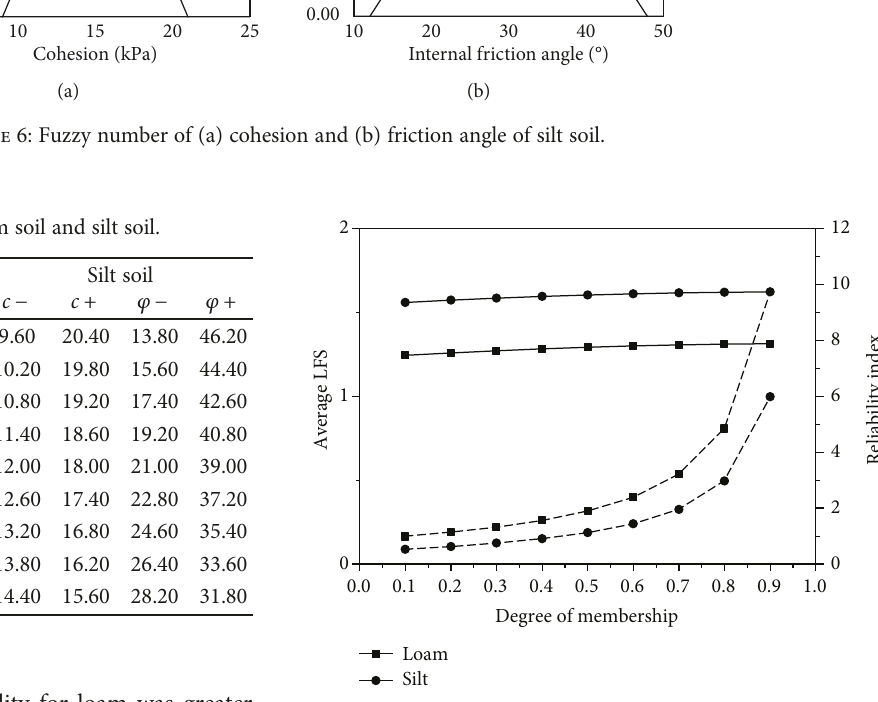
Figure 7: Average LFS, reliability index, and membership at observation points in the loam and silt soil